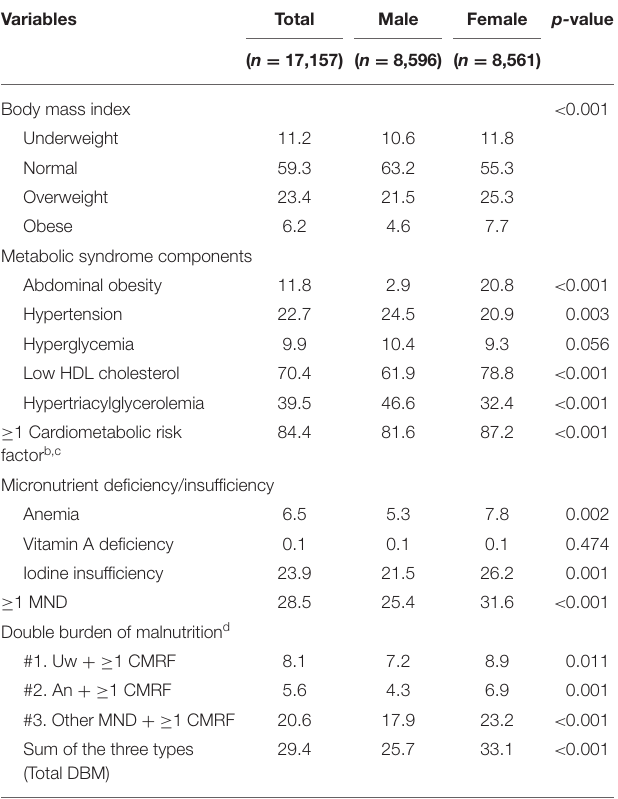
TABLE 2 | Nutritional status, cardiometabolic risk factors, and double burden of malnutrition of adults in the Philippines a . Variables